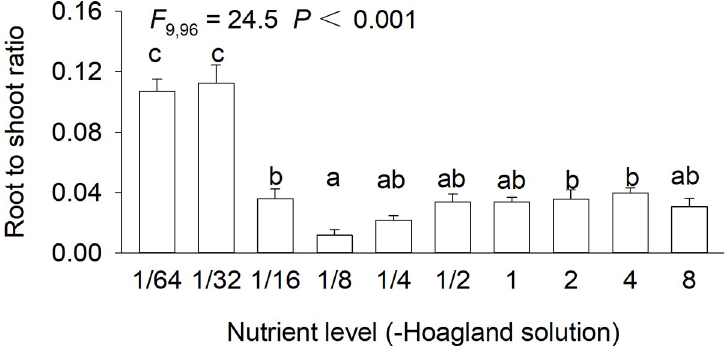
Fig 3. Root to shoot ratio of Spirodela polyrhiza grown in ten concentrations of Hoagland nutrient solution. Bars and vertical lines indicate means and SE (n = 12). F-statistics, df and P-values of one-way ANOVA for the effects of nutrient level are also given. Bars sharing the same letters are not different at P =